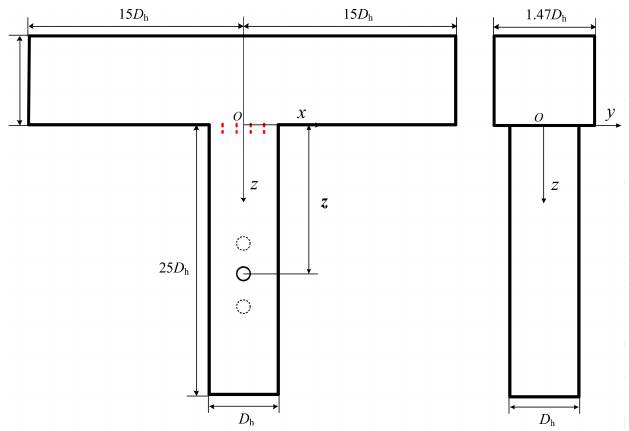
Figure 6. Computational domain in numerical investigation.